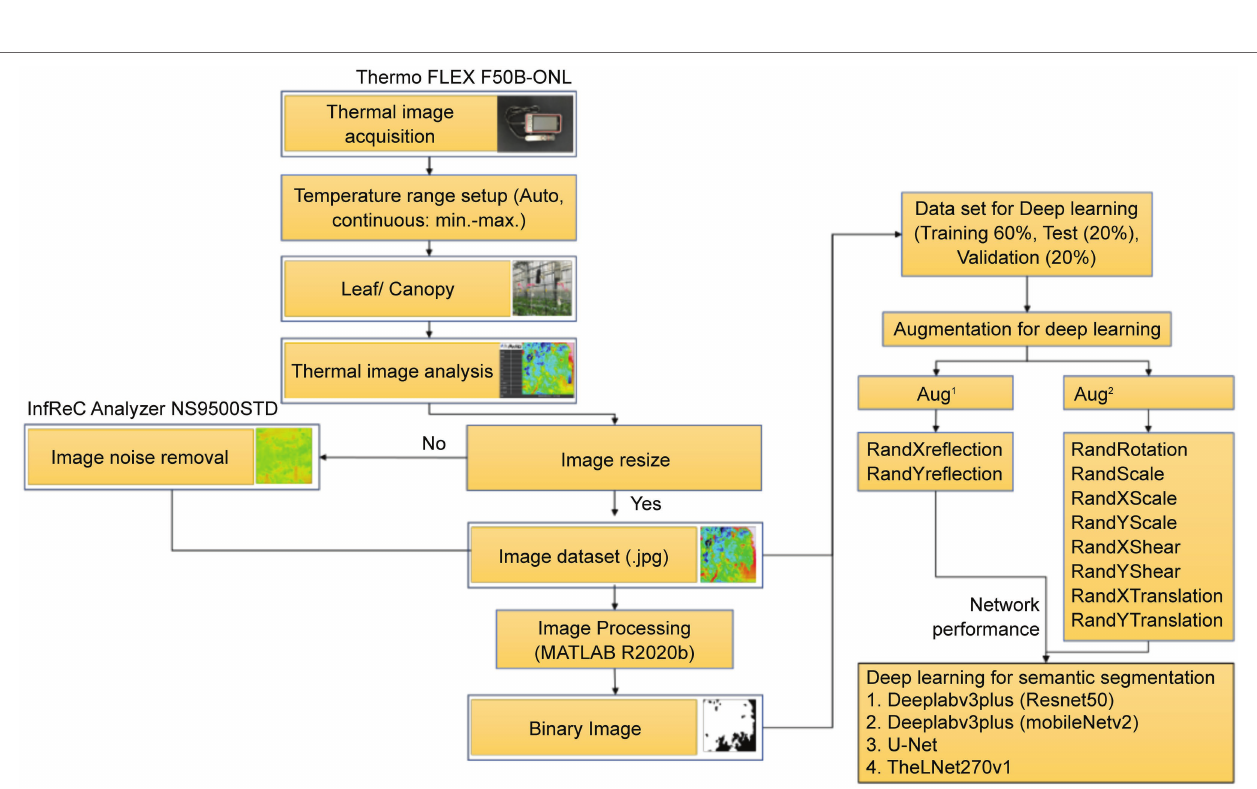
FIGURE 4 | Schematic diagram of the image dataset